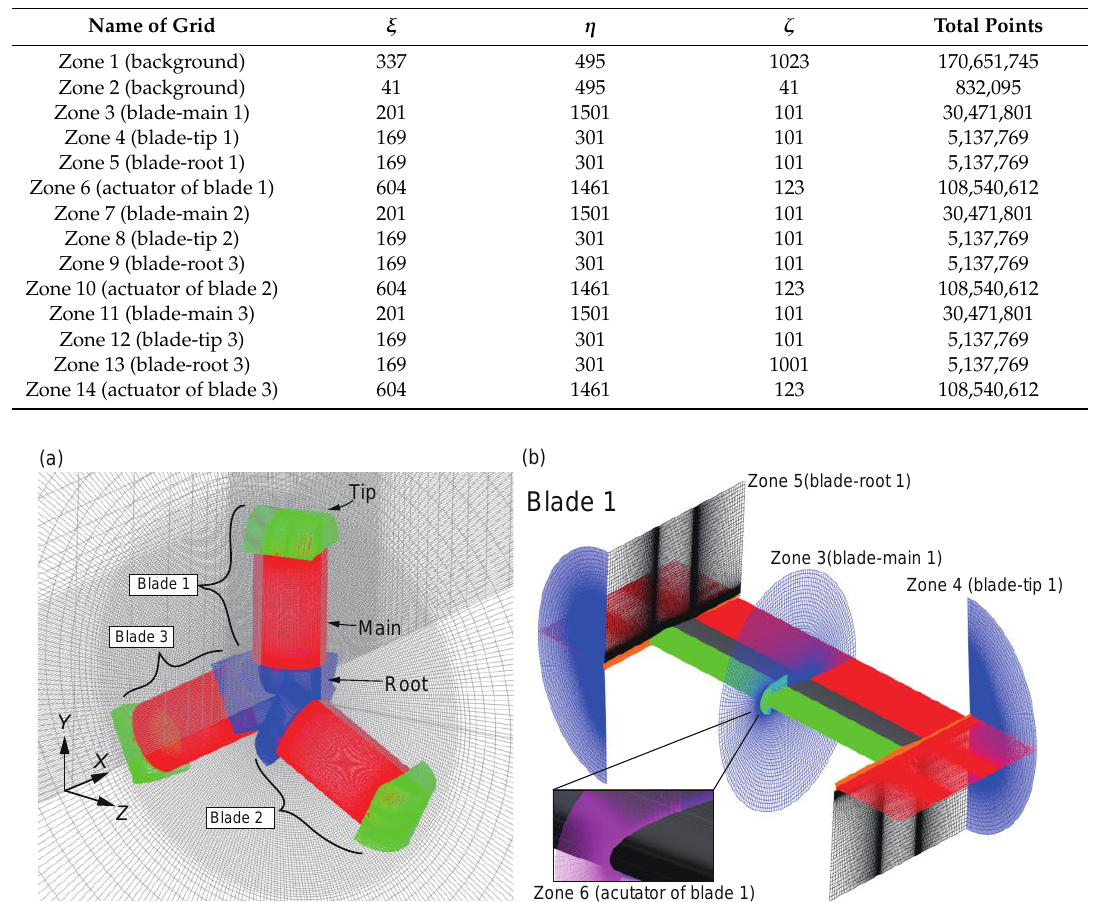
Table 3. Number of computational grid points.